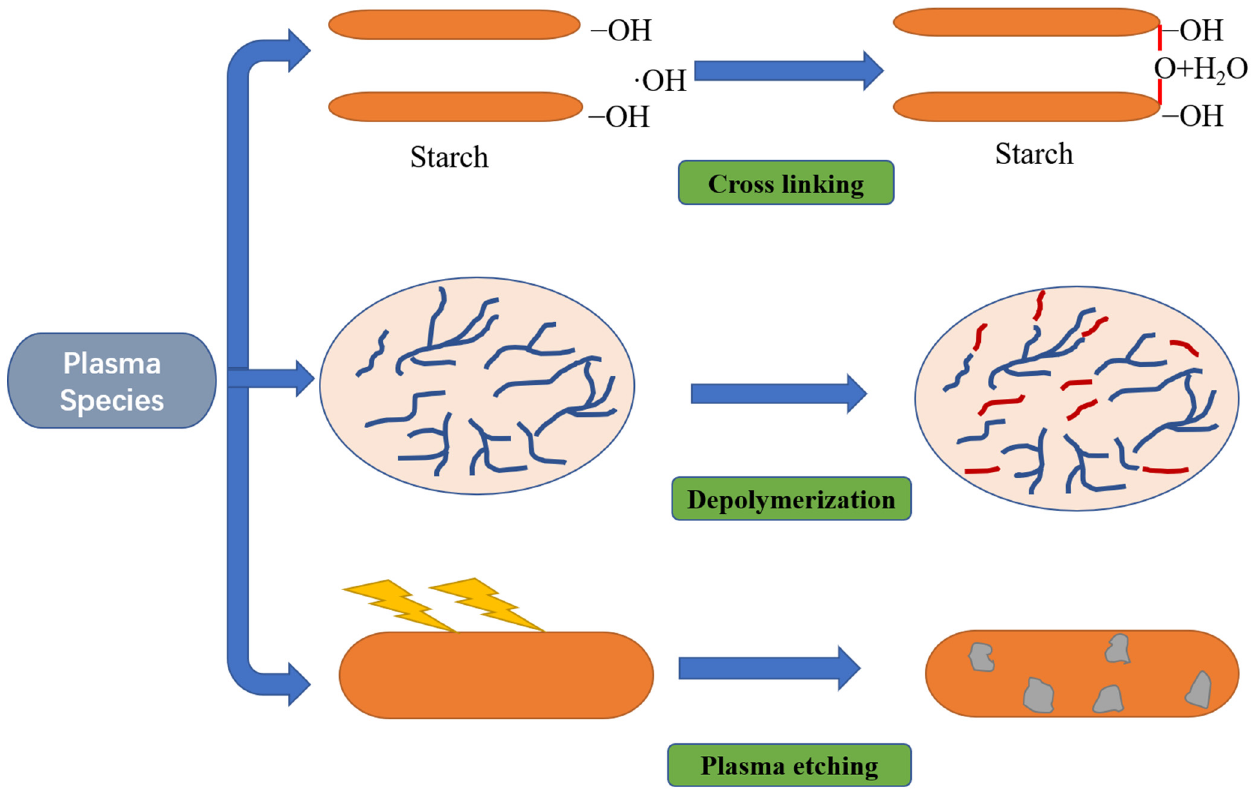
Figure 4. The effect of cold plasma on starch, adapted from [80].